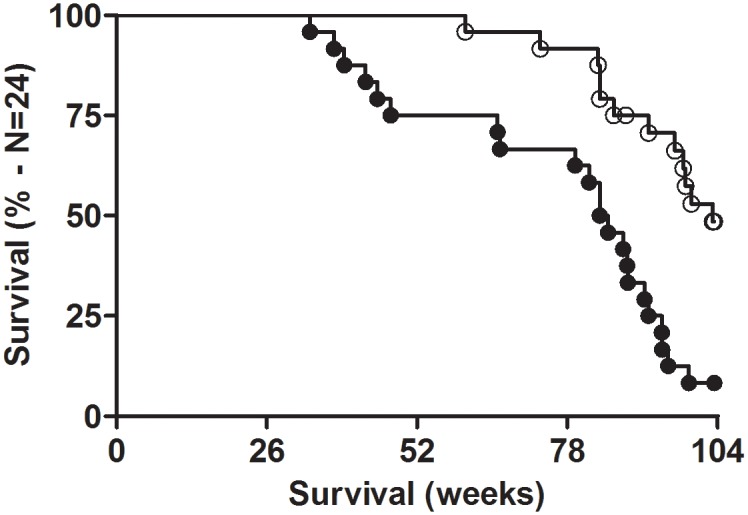
Survival proportion of rats after repeated daily exposure to SRS source.Empty circles = sham; black circles = exposed. Survival curves were significantly different (p < 0.001).